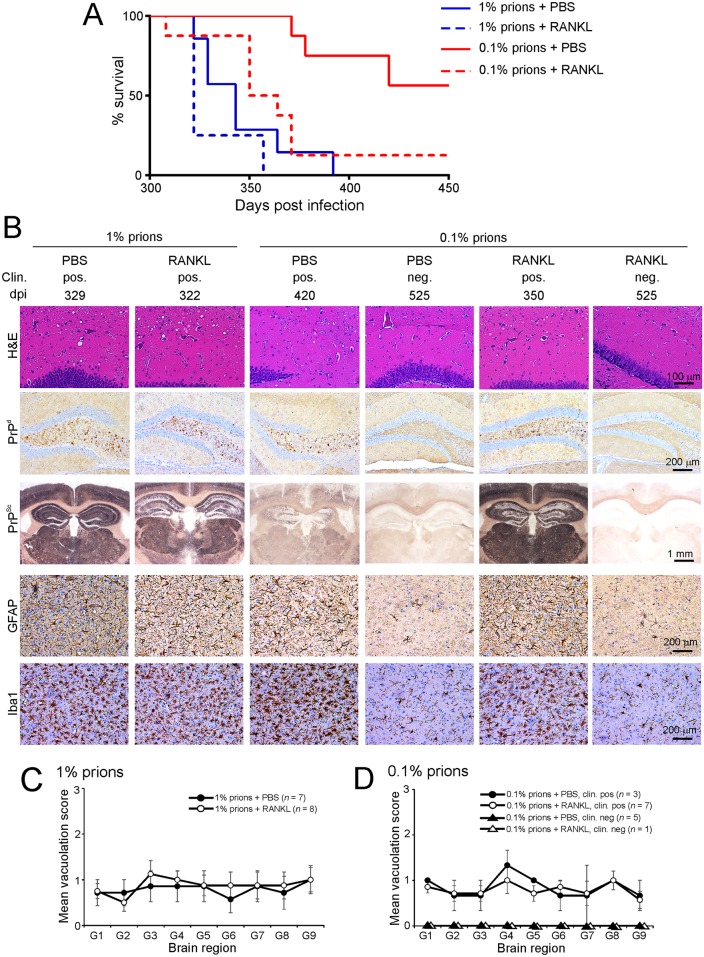
RANKL treatment significantly enhances susceptibility to oral prion disease.C57BL/6 mice were treated daily for 4 d with RANKL (or PBS as a control) to induce M cell-differentiation, and orally-exposed to a moderate (1% scrapie brain homogenate) or limiting (0.1%) dose of ME7 scrapie prions between the 3rd and 4th treatments. A) RANKL-treatment significantly increased disease susceptibility following oral exposure to a limiting dose of prions. Clinical prion disease survival curves for PBS- (solid lines) or RANKL-treated mice (broken lines) orally exposed to either a 1% (blue lines) or 0.1% (red lines) dose of prions (PBS/1% vs. RANKL/1%, P = 0.120; PBS/0.1% vs. RANKL/0.1%, P<0.0078; PBS/1% vs. RANKL/0.1%, P = 0.205; Log-rank [Mantel-Cox] test). B) High levels of spongiform pathology (H&E, upper row), heavy accumulations of PrPd (brown, second row) and disease-specific PrPSc (PET immunoblot, black, third row), reactive astrocytes expressing GFAP (brown, fourth row) and active microglia expressing Iba1 (brown, bottom row) were detected in the brains of all orally-exposed mice with clinical prion disease. However, none of these histopathological signs of prion disease were detected in the brains of any of the clinically-negative mice up to at least 525 d after oral exposure. Clin., clinical prion disease status; pos., clinically positive; neg., clinically negative; individual survival times are shown (dpi, days post infection). Sections were counterstained with haematoxylin to detect cell nuclei (blue). C&D) The severity and distribution of the spongiform pathology (vacuolation) within each brain was scored on a scale of 1–5 in nine grey matter areas: G1, dorsal medulla; G2, cerebellar cortex; G3, superior colliculus; G4, hypothalamus; G5, thalamus; G6, hippocampus; G7, septum; G8, retrosplenial and adjacent motor cortex; G9, cingulate and adjacent motor cortex; Each point represents the mean vacuolation score ± SD.